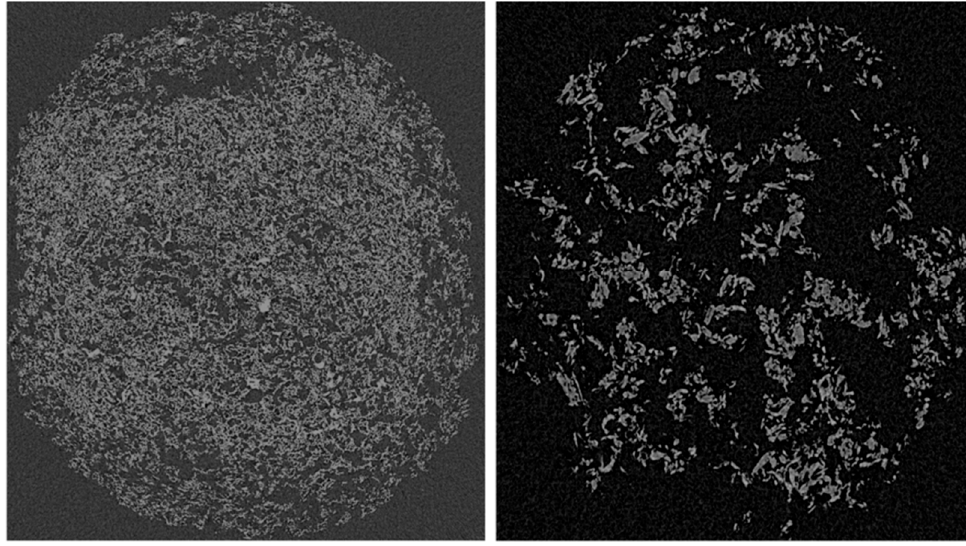
Figure 1. CT scan of the extracted polyethylene ( left ) and polypropylene ( right ).